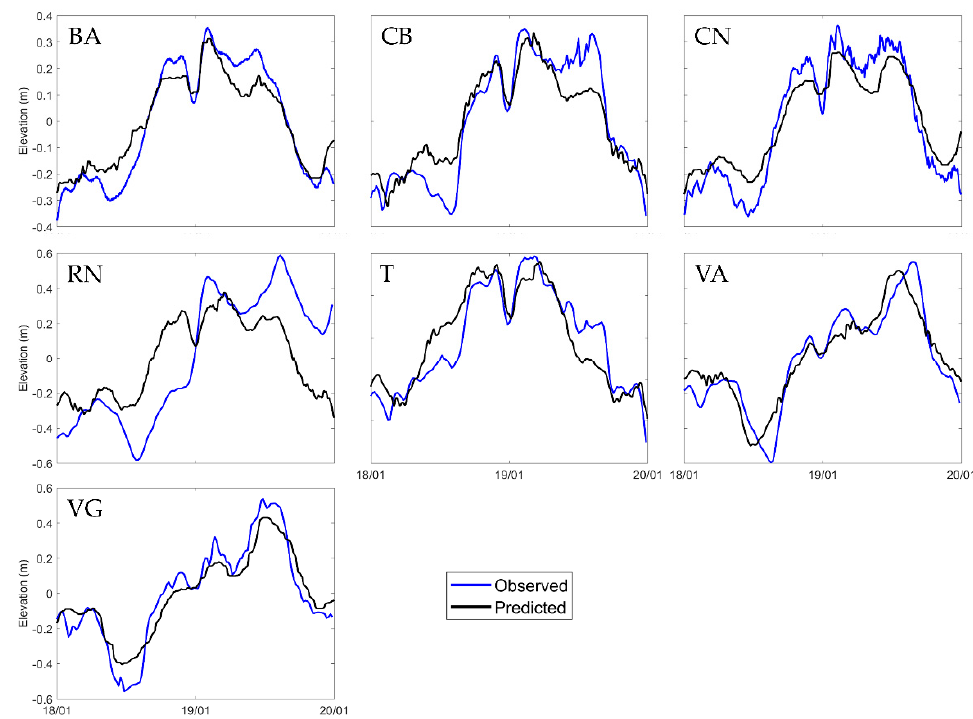
Figure 4. Residuals for observations (blue line) and model results (black line) under the storm surge event in January 2013. Table 8. Model performance under storm surge propagation resulting from the validation proce- dure.